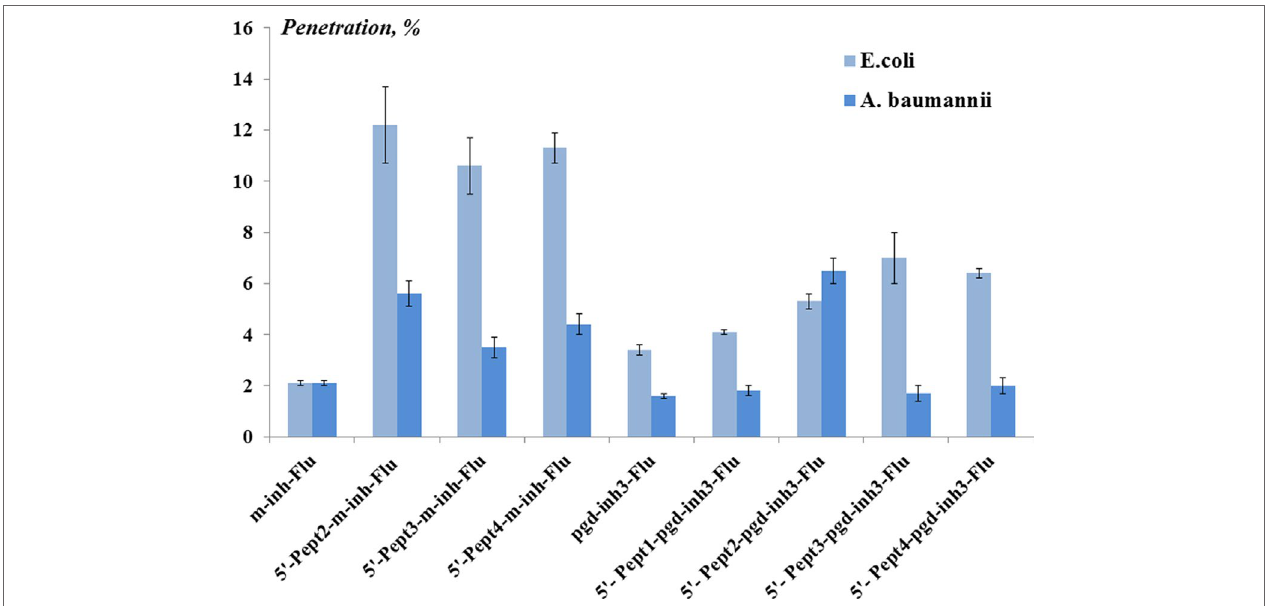
FIGURE 5 | The level (%) of oligonucleotide conjugates penetration in Escherichia coli and Acinetobacter baumannii obtained by flow cytometry. The concentration of the conjugates was 1 μM. The cells were incubated with conjugates for 1 h at 37°C. The results are mean values (± SD) from four independent experiments. The fluorescence of the sample of bacterial cells incubated with fluorescein-labeled peptide conjugate of the oligonucleotide is taken as